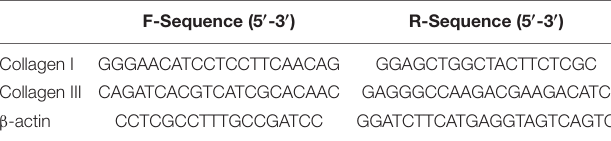
TABLE 2 | Clinical characteristics of developmental dysplasia of the hip (DDH)